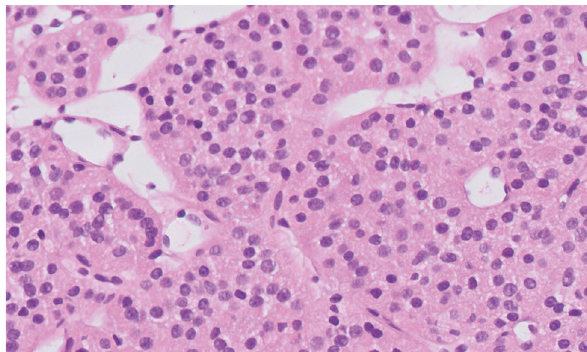
Figure 1: Oncocytoma biopsy specimen, H&E staining, × 20 magnification, digitally